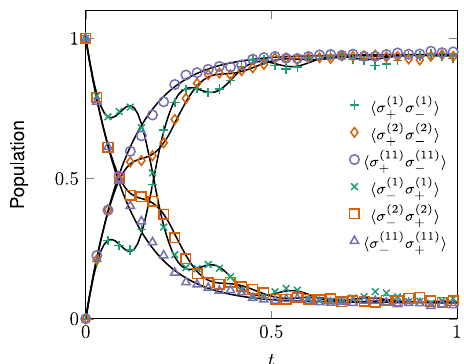
Fig. 5 Site populations in a long qubit chain. Population of sites 1, 4, and 11 for the qubit chain (22) with L = 11. The marks show the result of the stochastic evolution and the full black lines the result of numerically integrating the master equation. The weights are Γ ℓ , t = γ , Γ ℓ + N , t = δ for ℓ = 1, … N ,